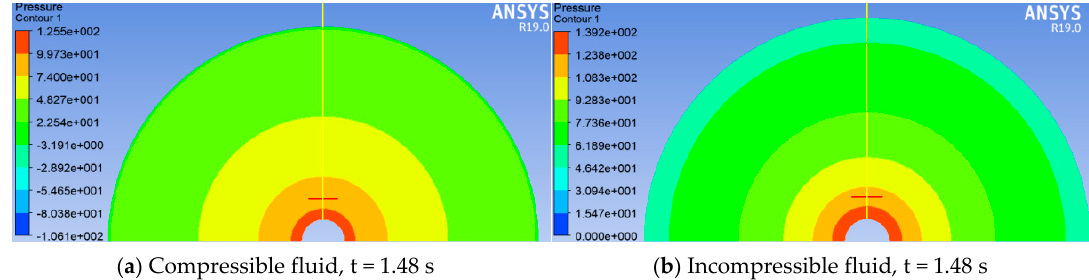
Figure 7. The plot of the velocity on the line X = 0, Y = (10,500) in case 2.